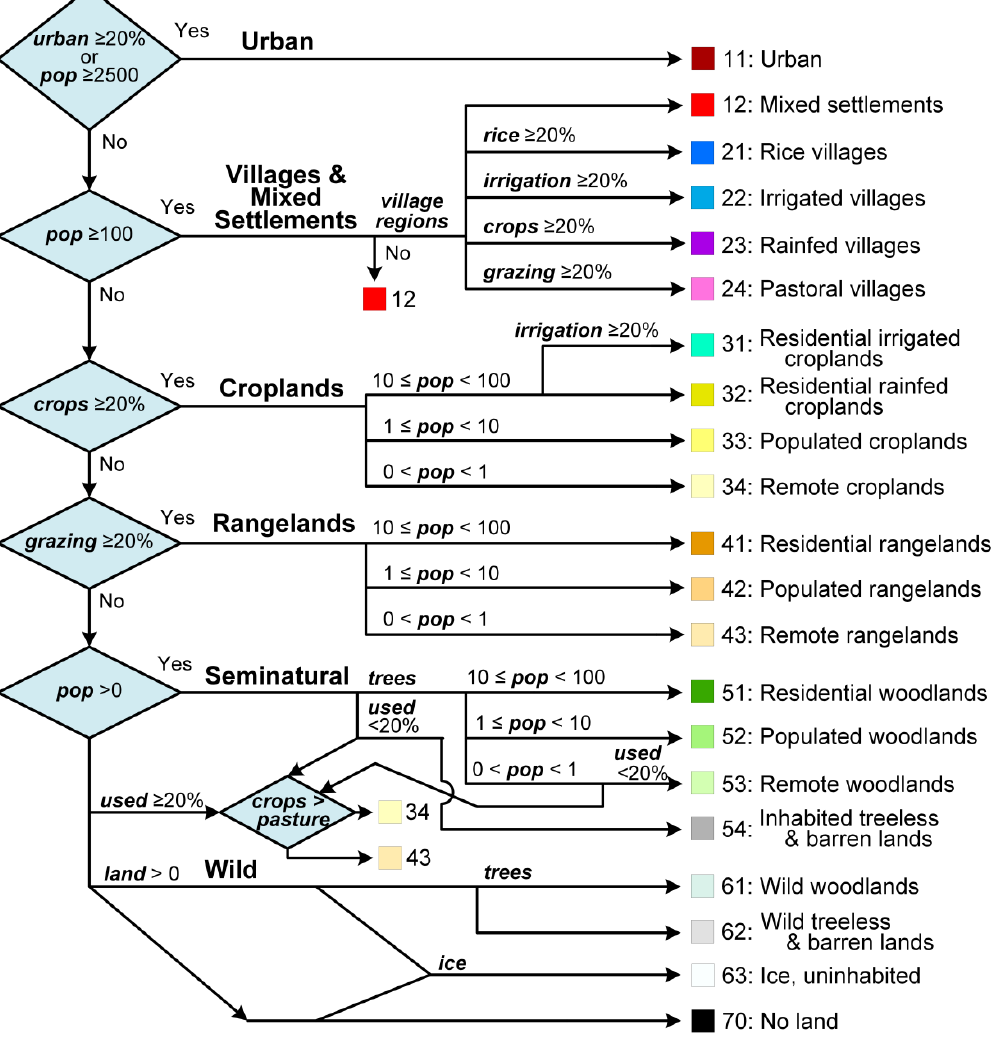
Figure A2. Anthromes v2.1 classification flowchart.